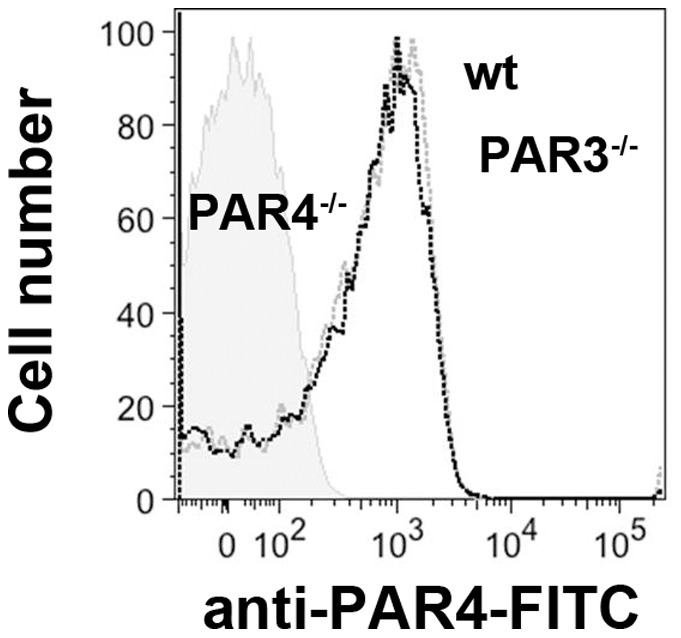
PAR4 expression on mouse platelets.Flow cytometric analysis of PAR4 expression in wild type (WT) (black line), PAR3−/− (gray line), and PAR4−/− (shaded) mice platelets using anti-PAR4-FITC antibodies.